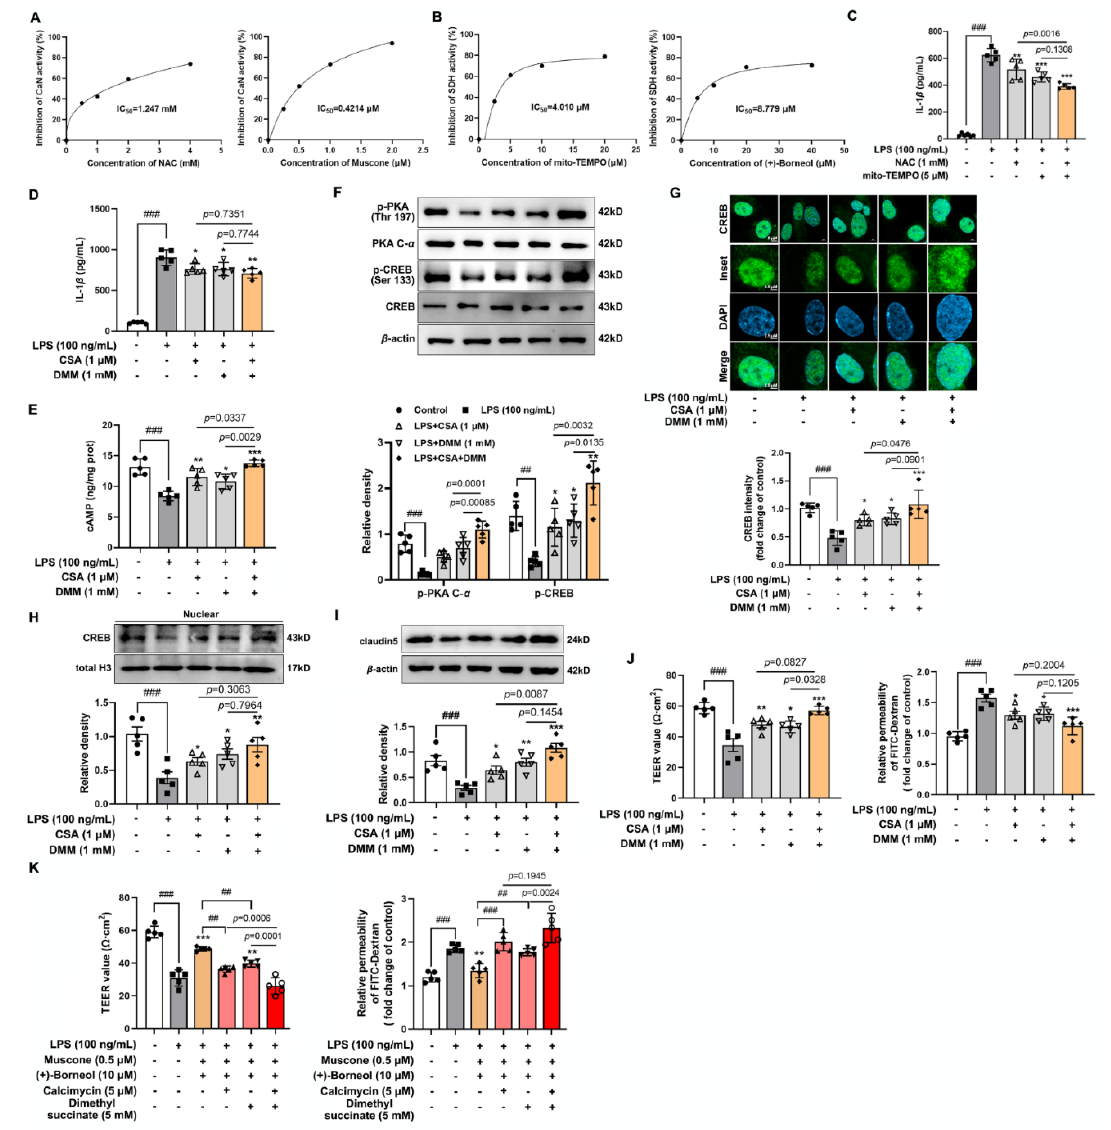
Figure 7. Calcium overload and succinate accumulation collaboratively suppress IL- 1 β /CREB/claudin 5 signaling in the context of oxidation stress. ( A ) bEnd.3 cells were given the indicated dosage of NAC or muscone. The activity of CaN was detected and IC 50 value was calcu- lated; ( B ) bEnd.3 cells were given the indicated dosage of Mito-TEMPO or (+)-borneol. SDH activity was detected and the IC 50 value was calculated; ( C , D ) the level of IL-1 β released in LPS-induced bEnd.3 cells with the indicated reagents; ( E ) cAMP level in the lysis of bEnd.3 cells when exposed to LPS stimulation ( n = 5); ( F ) protein levels of p-PKA C, PKA c- α , p-CREB (Ser 133), and CREB in LPS-stimulated bEnd.3 cells; ( G ) immunofluorescence staining indicated nuclear translocation of CREB when treated with CSA and DMM in the presence of LPS ( n = 5, scale bar: 5 µ m or 2.5 µ m); ( H ) protein expression of CREB in the nucleus of LPS-stimulated bEnd.3 cells ( n = 5); ( I ) protein expression of claudin 5 in LPS-induced bEnd.3 cells ( n = 5); ( J , K ) the TEER values and the diffusion of FITC-dextran through the bEnd.3 cells were measured with the indicated reagents ( n = 5). Data are presented as mean ± SD ( n = 5). * p < 0.05, ** p < 0.01, *** p < 0.001 vs. LPS treatment; ## p < 0.01, ### p < 0.001 vs. indicated treatment. p values are determined by one-way ANOVA followed by Tukey’s